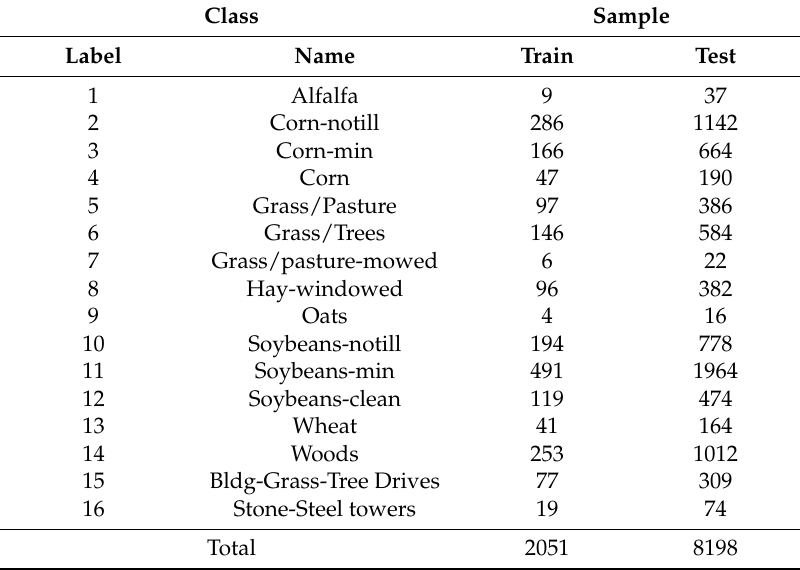
Table 1. The ground truth of training and testing samples in each class for Indian Pines dataset.